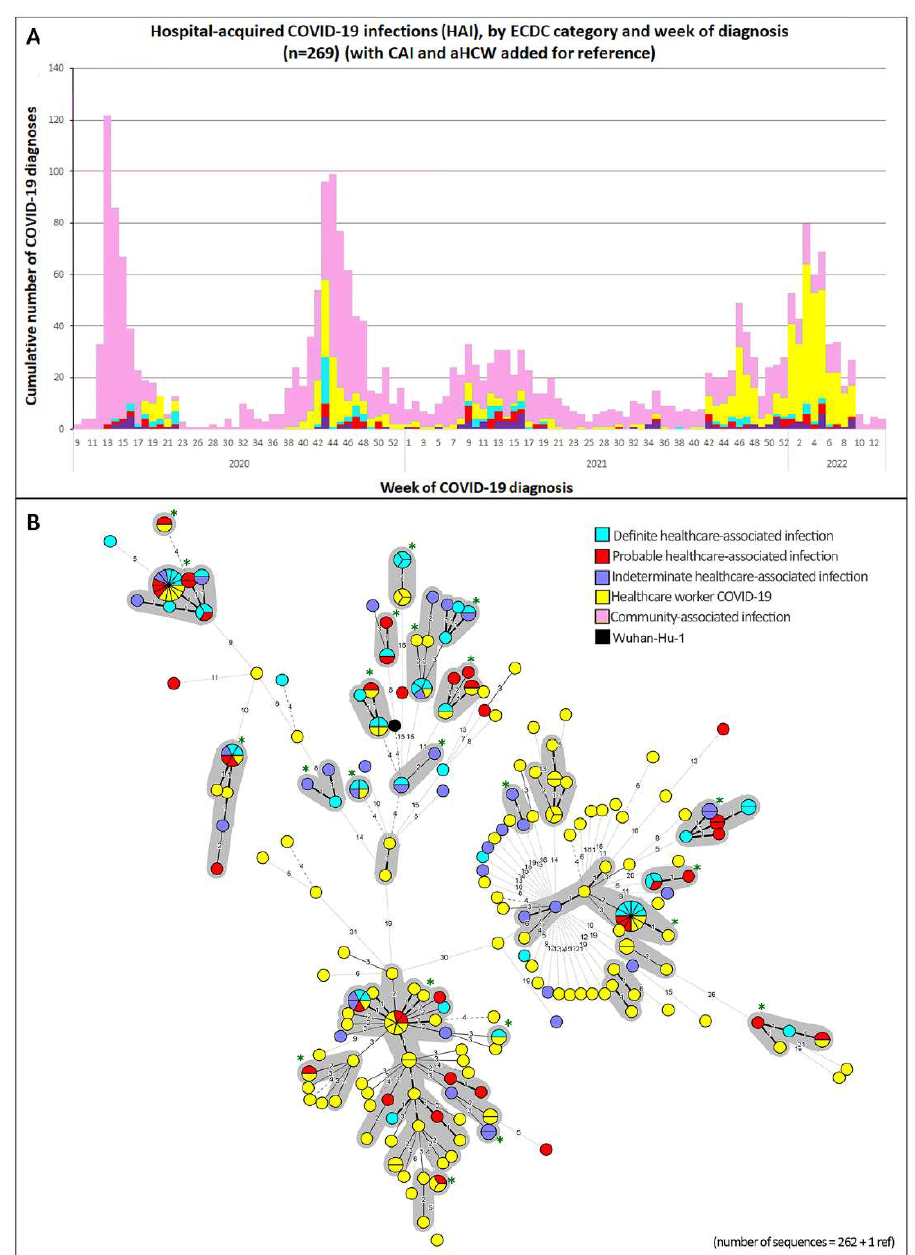
Figure 3. Epicurve and minimum spanning tree (MST) of hospital-acquired infections (HAIs) ( n = 269) by ECDC case source definition and week of diagnosis (aHCWs and CAIs were included for reference). ( A ) Epicurve of our cases showing all HAIs by ECDC categories and by week. CAIs (pink) and aHCWs (yellow) are shown for reference. ( B ) MST (minimal spanning tree) of SARS-CoV-2 genomes of the patients whose samples were available for sequencing. The black genome represents the reference genome Wuhan-Hu-1 [18]. The size of the circles is proportional to the number of cases. Genomes that differed by ≤ 2 SNPs were clustered using the grey contours (HAI and aHCW together). Green asterisks are used to show the 22 clusters that contained at least 1 HAI case.